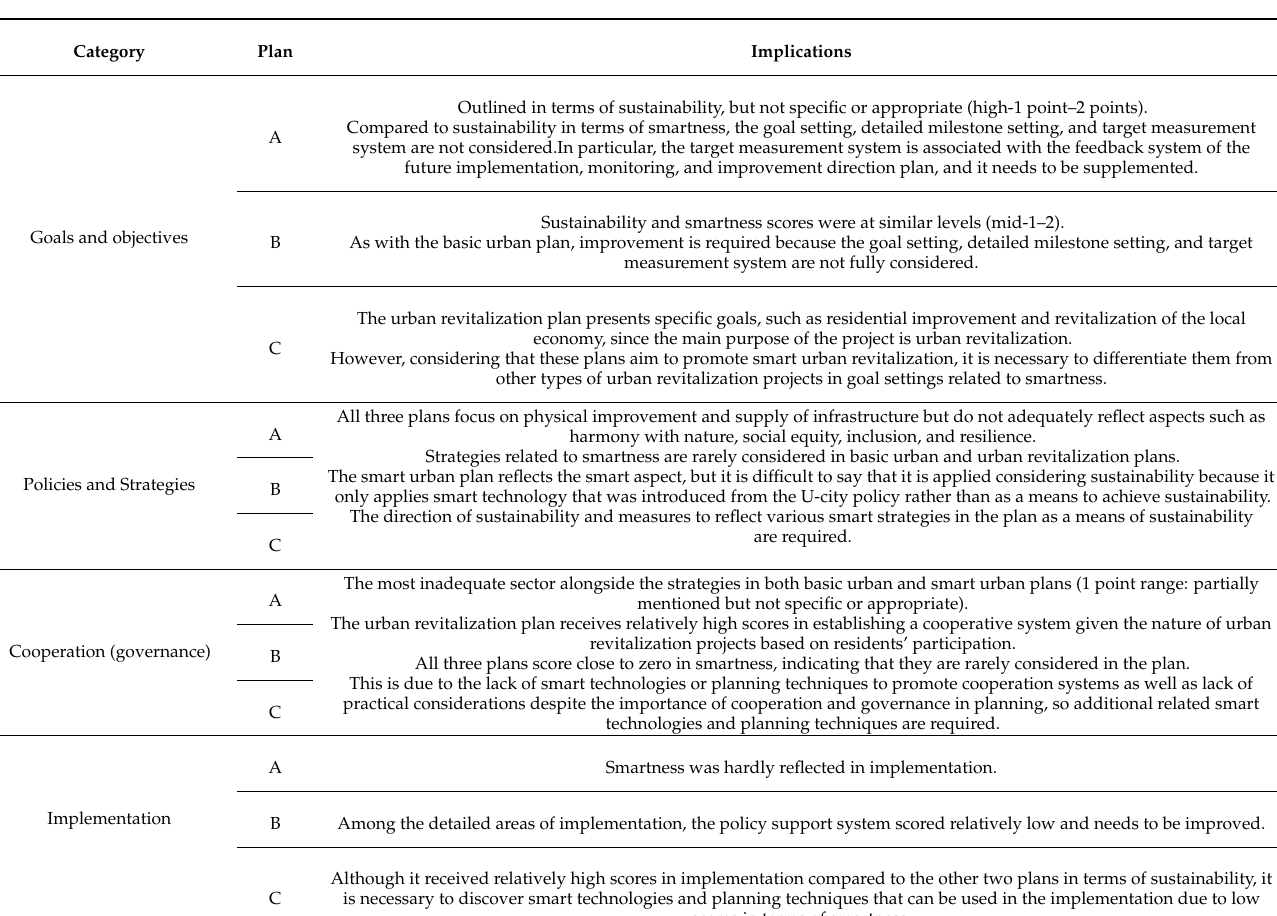
Table 3. Considerations for